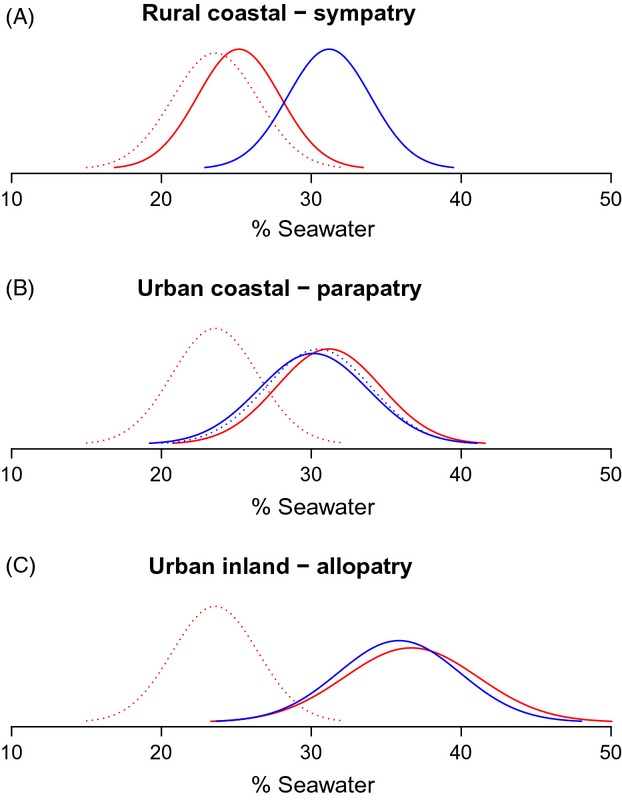
Evidence for ecological character displacement in populations of An. gambiae (red) and An. coluzzii (blue) from Central Africa. The Gaussian curves show the probability density functions of tolerance thresholds, according to habitat, location and degree of syntopy. The dotted red curve in all panels depicts the tolerance of inland rural forest populations of An. gambiae, which are postulated to represent the ancestral state of the trait. Panel (A) includes localities where both species extensively share the same breeding sites, whereas in (B), both species share the same locality but not the same breeding sites due to spatial segregation (Libreville, Gabon). The dotted blue line refers to coastal urban populations of An. coluzzii in allopatry, where An. gambiae does not occur (Bonaberi/Douala, Malabo, Tiko). In (C), both species share the same habitat but not the same localities, each locality being exclusive of one of the two taxa; An. gambiae urban populations are represented by towns located in the savanna (Tibati, Cameroon) or in the forest westwards of the Cameroon Volcanic line (cf. Figs1–1 and Table S1).